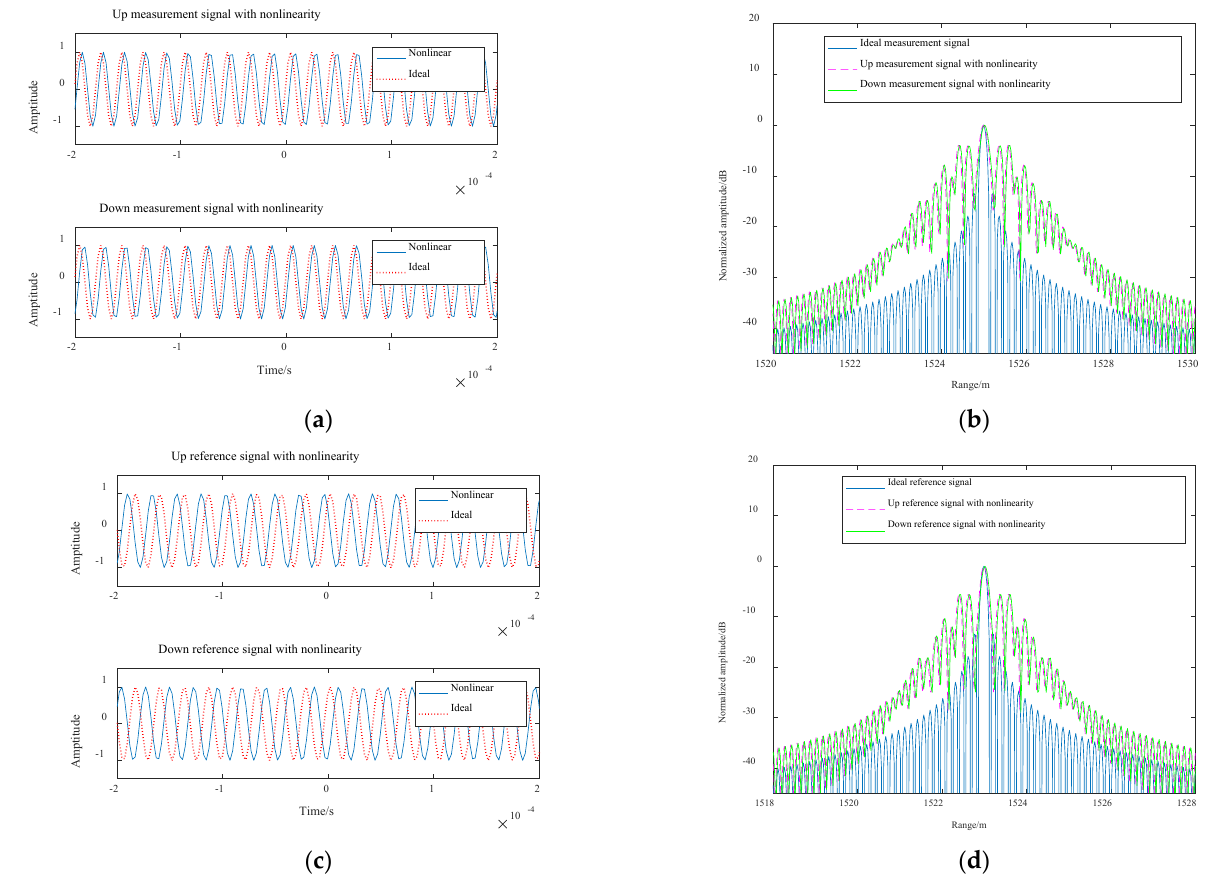
Figure 5. ( a ) Up and down measurement dechirp signals with nonlinearity error; ( b ) One − dimensional range profiles of the measurement dechirp signals; ( c ) Up and down reference dechirp signals with nonlinearity error; ( d ) One − dimensional range profiles of the reference dechirp signals.